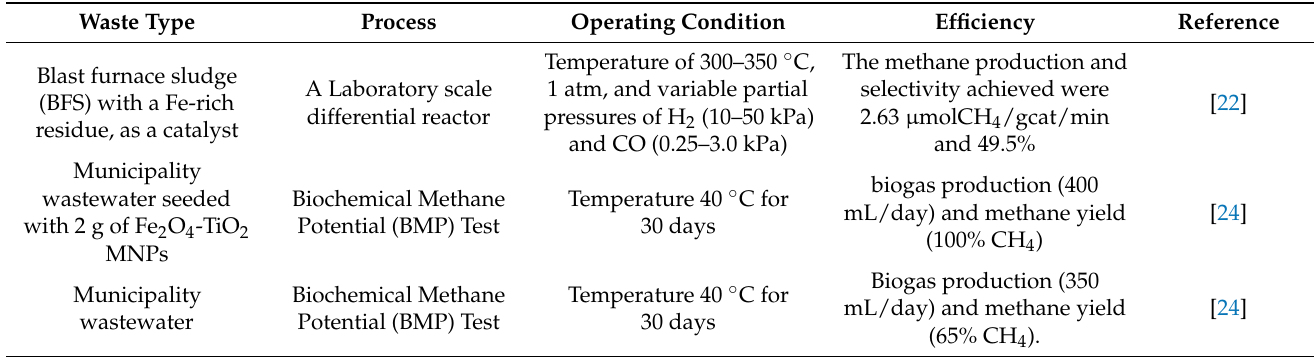
Table 6. Comparing previous and current studies.